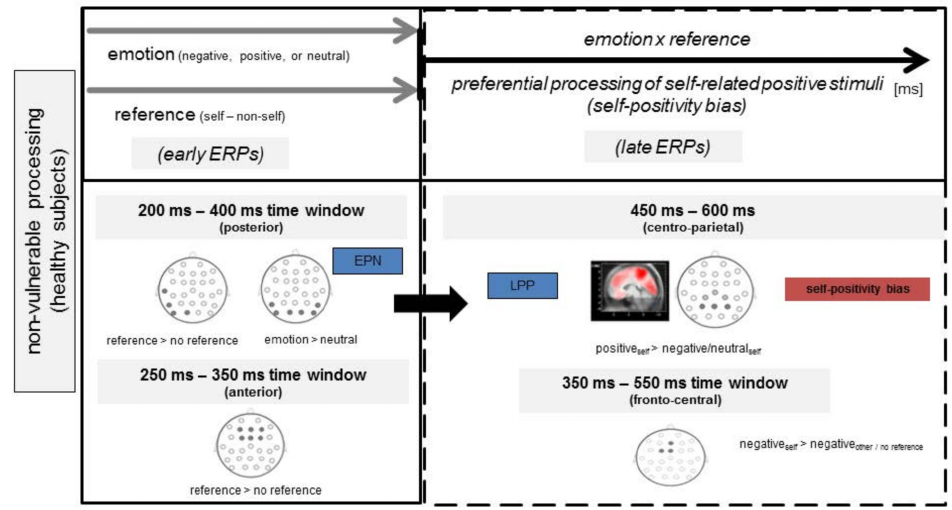
Figure 3. Cascade of processing steps preceding and underlying the self-positivity bias during reading of self-referential and other-referential pronoun-noun and non-referential article-noun pairs according to the results from